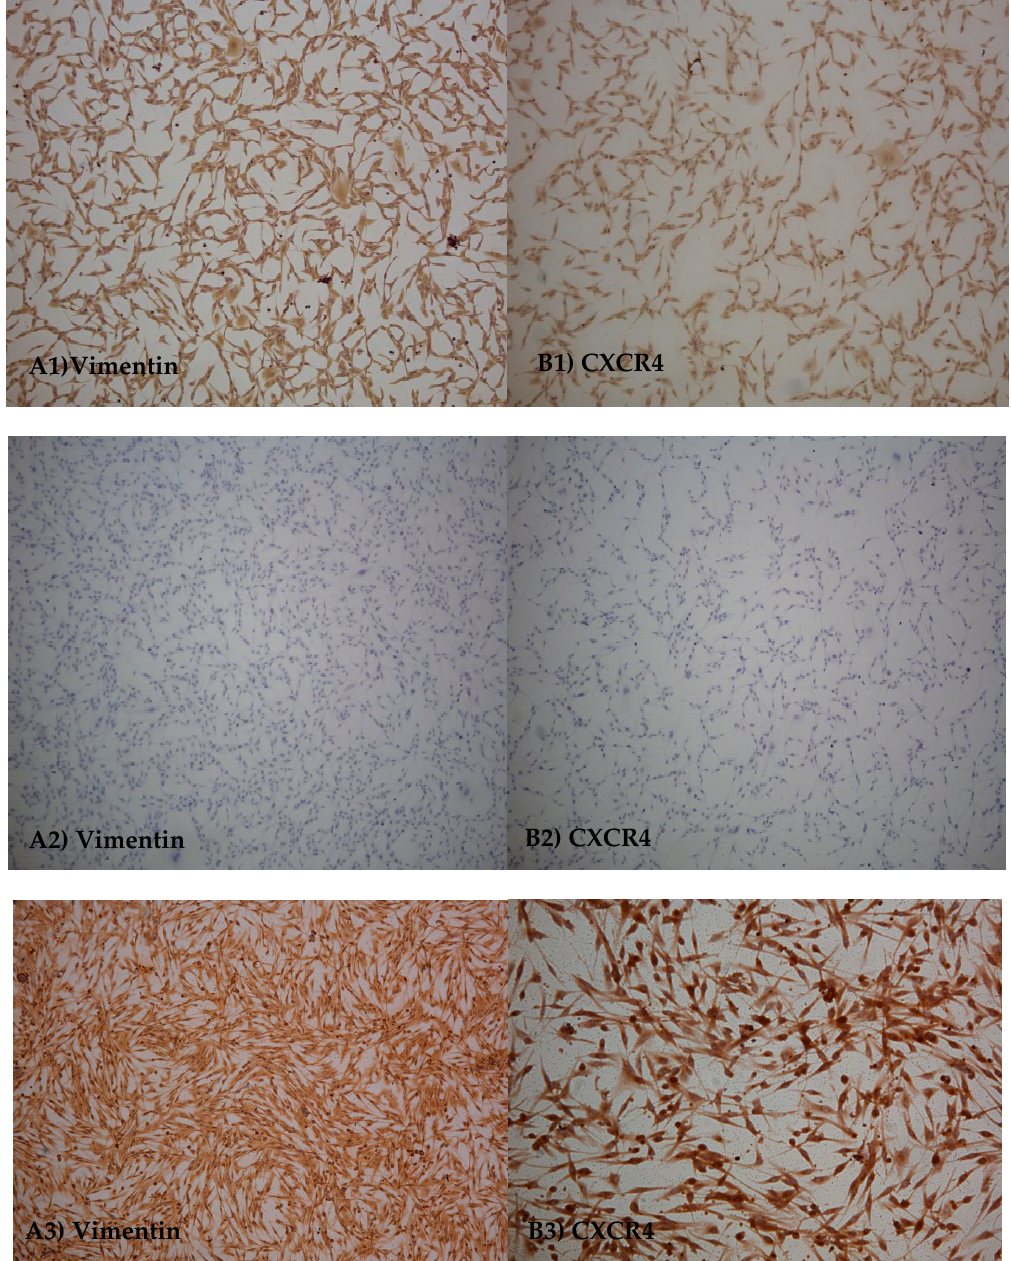
Figure 4. Immunocytochemical assay. Representative images: Vimentin ( A1 ) and CXCR4 ( B1 ) protein expression on D-17 cell line; negative control ( A2 , B2 ); positive control ( A3 , B3 ).